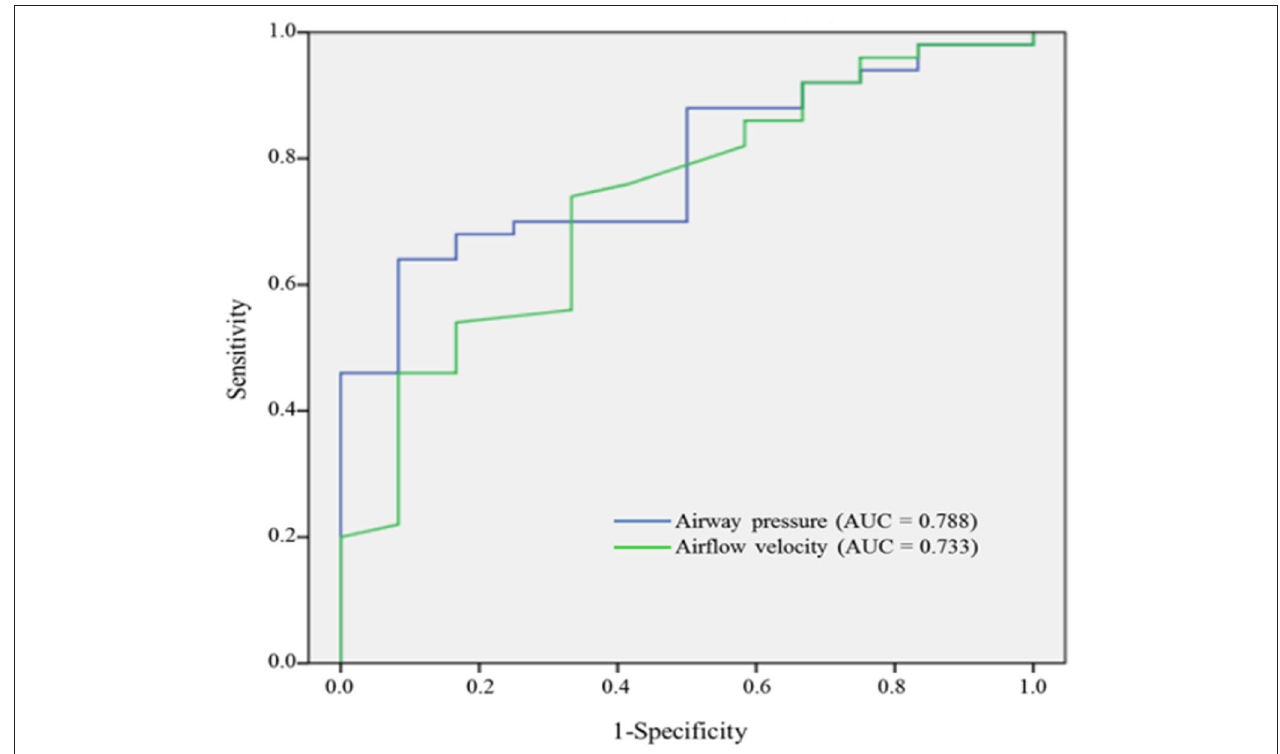
FIGURE 4 | AUROC curves of airway pressure and airflow velocity for predicting moderate to severe OSA.